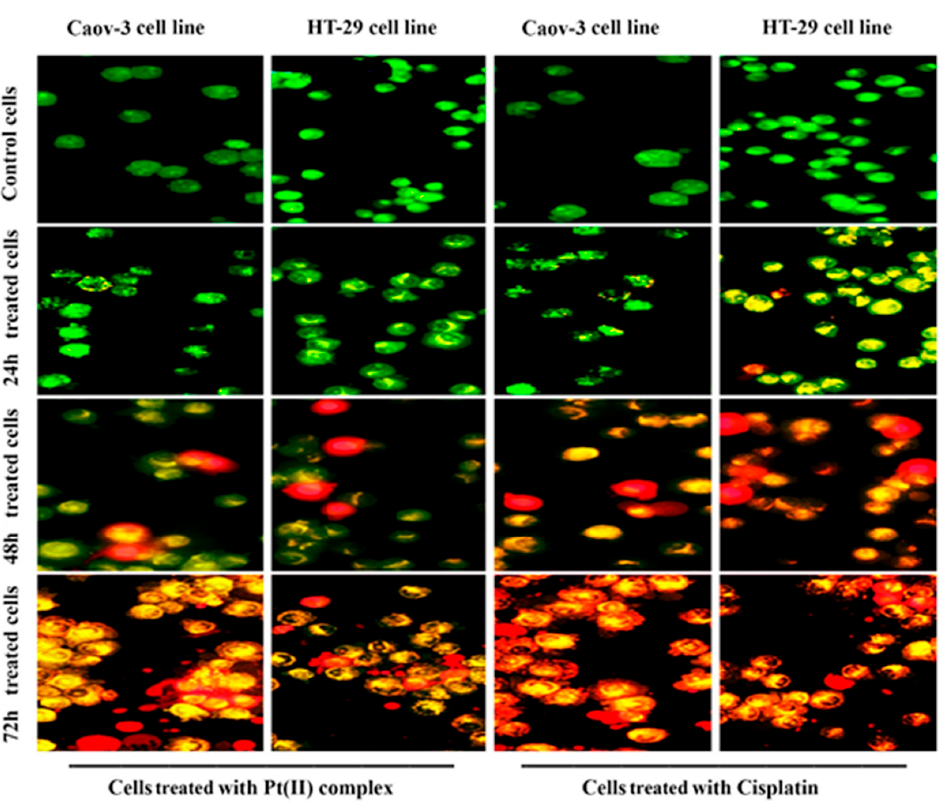
Figure 2. Fluorescence microscopy images of cell lines stained with AO and PI. Cells were treated with IC 50 concentrations of [Pt(H 2 L)(PPh 3 )] complex at different